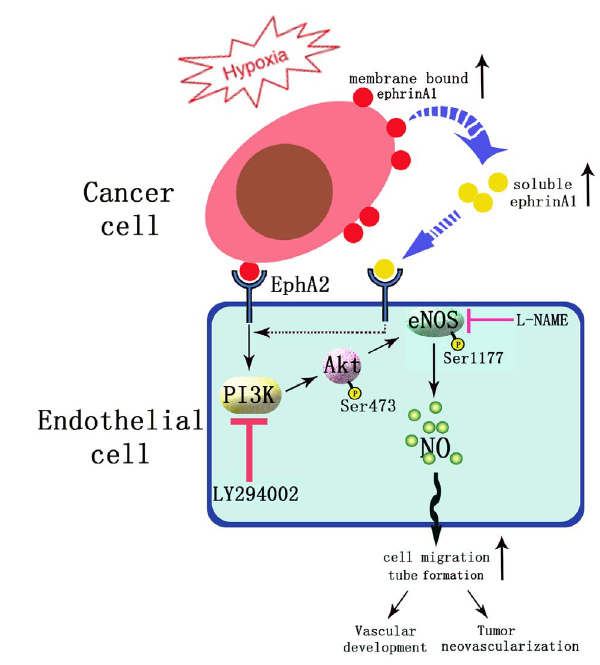
Figure 6. Schematic representation of signaling cascade involved in hypoxia-inducible ephrin-A1 modulation of angio- genesis in tumor hypoxic microenvironment.